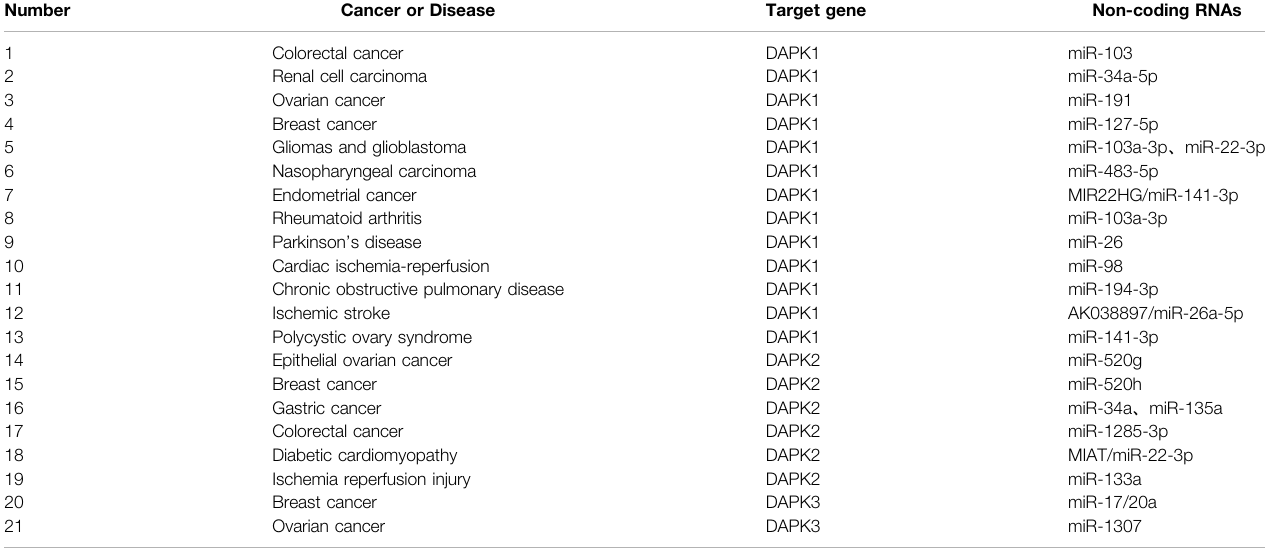
TABLE 1 | Non-coding RNAsin the regulation of DAPKs. Number Cancer or Disease Target gene Non-coding